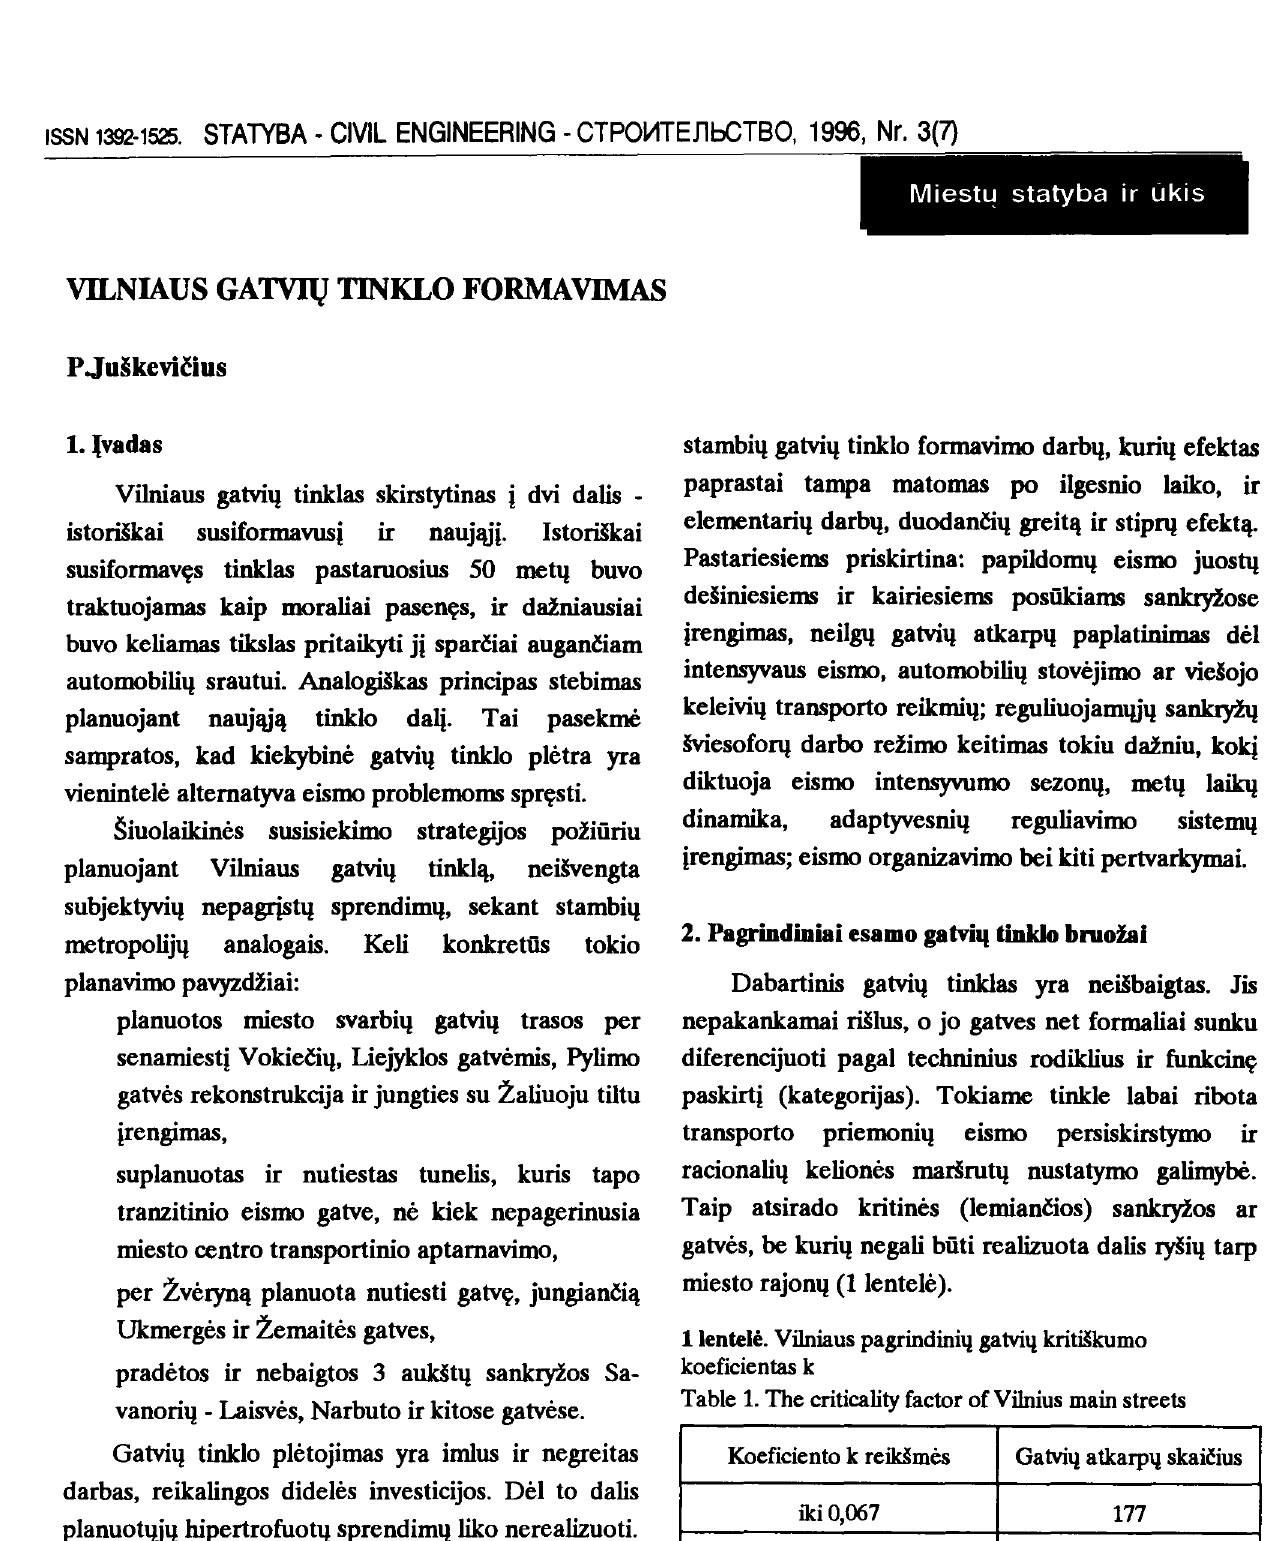
Table 1. The criticality factor of Vilnius main streets Koeficiento k